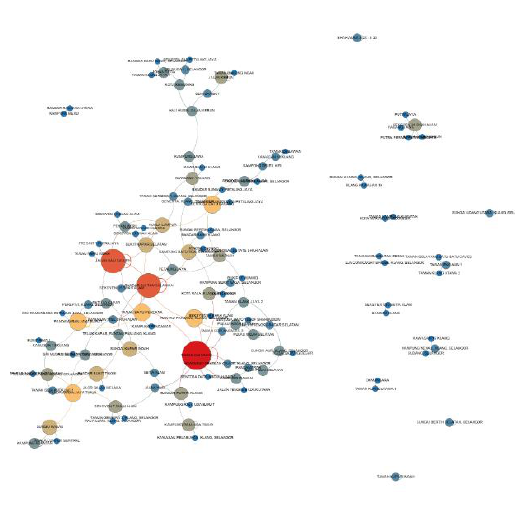
Figure 9. Network graph of TB patient mobility.